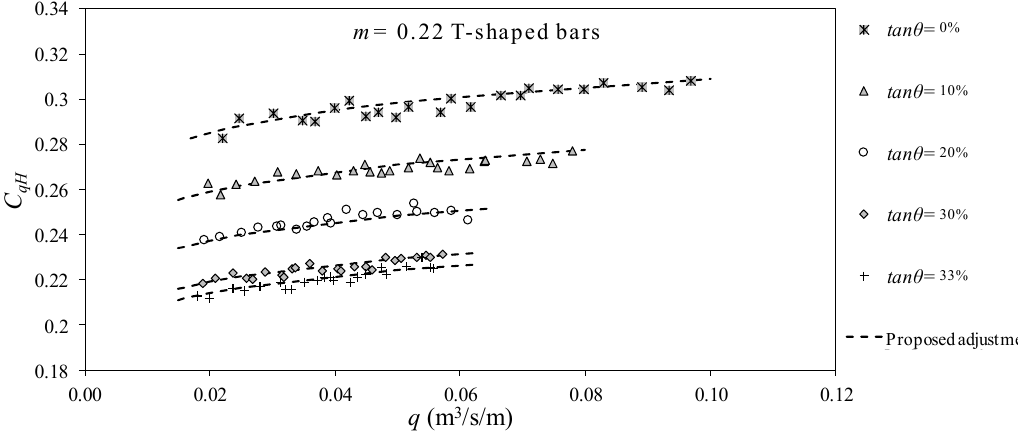
Figure 24. Mean discharge coefficient C qH as a function of the incoming flow q , for T-shaped flat bars with void ratio m = 0.22.